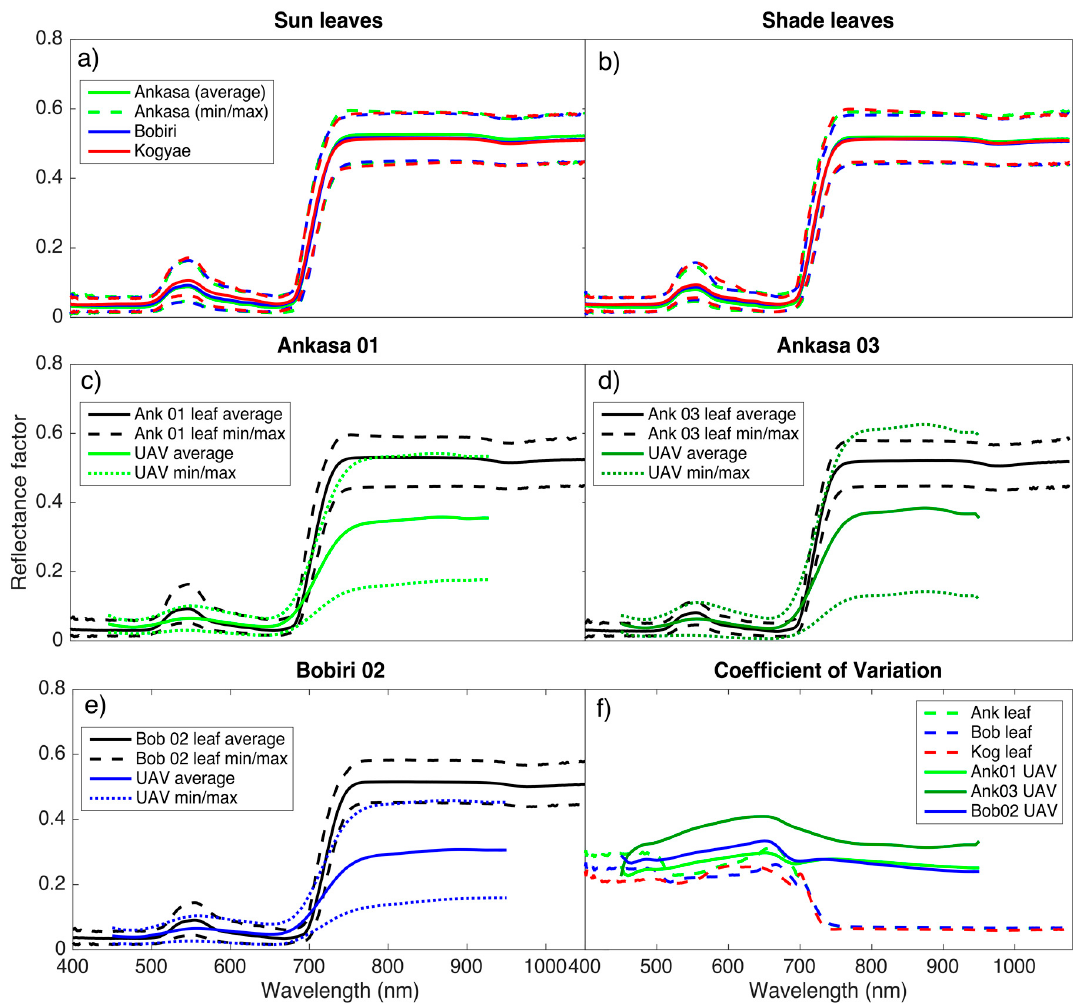
Figure 3. ( a , b ) Mean, maximum and minimum leaf reflectance spectra of all field-collected sun and shade leaves for Ankasa (green), Bobiri (blue) and Kogyae (red). ( c – e ) Mean, maximum and minimum UAV-collected spectra for Ankasa 01 (bright green), Ankasa 03 (dark green) and Bobiri 02 (blue). The corresponding mean, maximum and minimum field-collected sun leaf spectra for the plot is shown in black for comparison purposes. ( f ) Mean coefficient of variation of field-collected sun and shade leaves for Ankasa, Bobiri and Kogyae represented by dashed lines. Mean coefficient of variation of the UAV-collected spectra for Ankasa 01, Ankasa 03 and Bobiri 02 represented by solid lines. The colours follow the same colour key